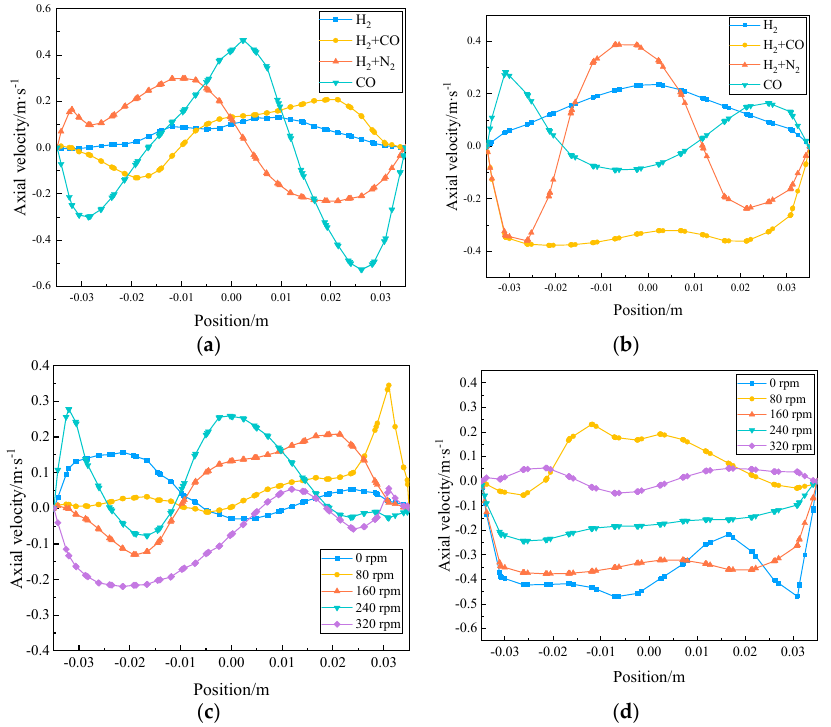
Figure 8. Axial velocity distribution of iron ore powder particles in diameter direction at 0.07 and 0.21 m height. ( a ) Different gas compositions at 0.07m; ( b ) Different gas compositions at 0.21m; ( c ) Different agitation speeds at 0.07m; ( d ) Different agitation speeds at 0.21m.